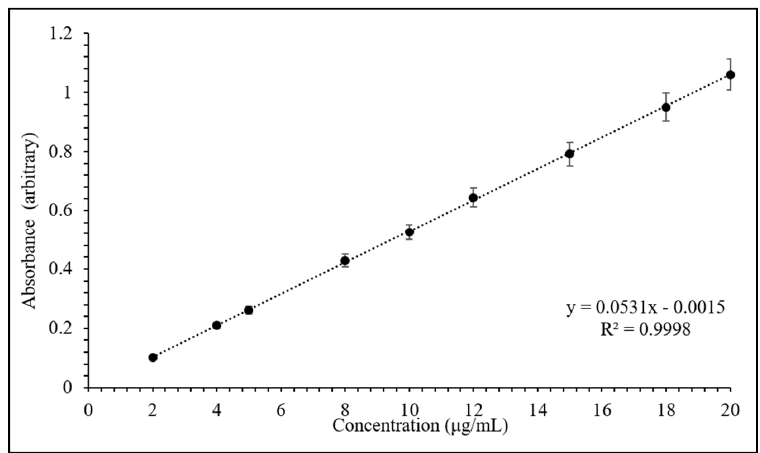
Figure 2. Calibration curve of theophylline (TP) in 0.1 N HCl at 270 nm. Values expressed are means with standard deviations as error bars, n = 3.